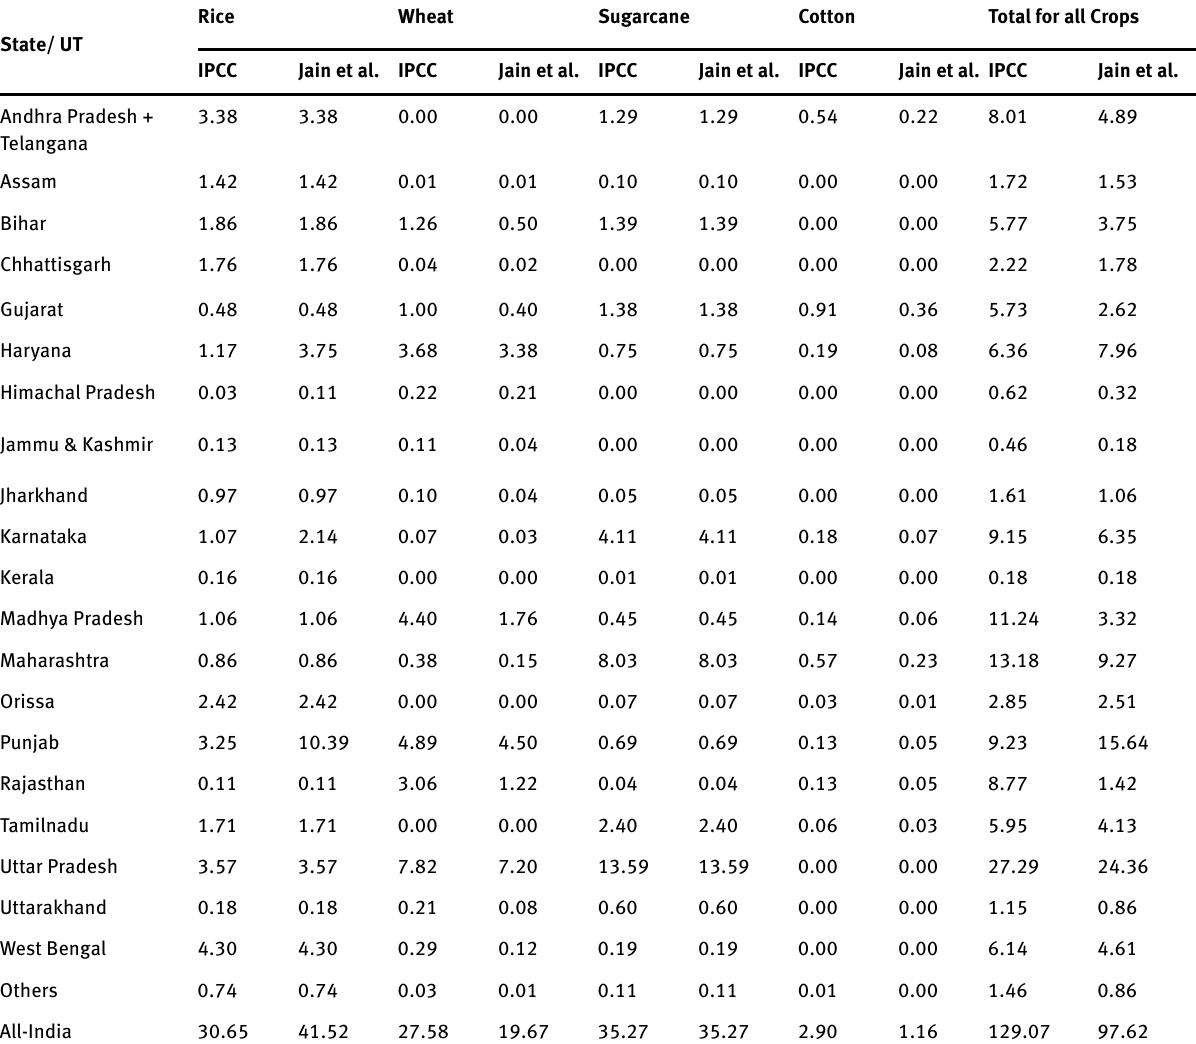
Table 6: Burning of crop residue (tonnes) State/ UT